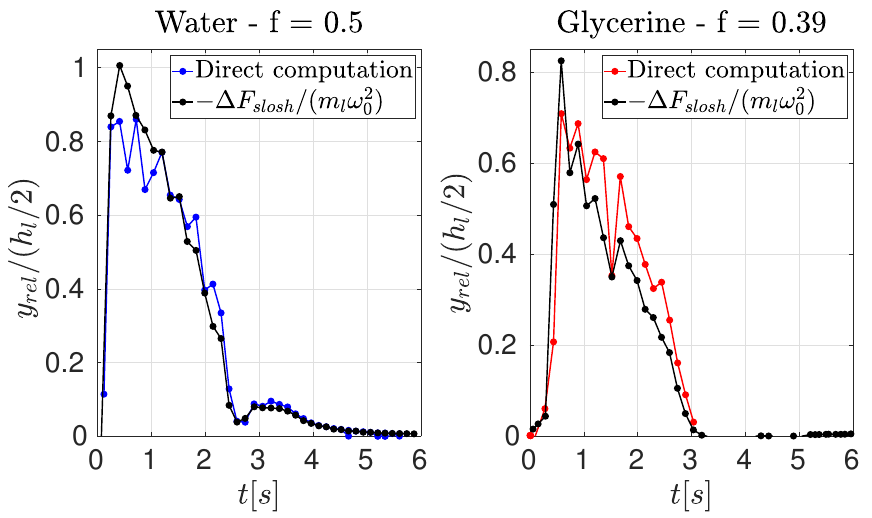
Figure 14. Nondimensional amplitude of the relative motion of the liquid center of gravity with respect to the tank over time for water f = 0.5 ( left ) and glycerine f = 0.39 ( right ). Comparation between SPH calculation and the expression given by Equation (26), − ∆ F slosh / ( m l ω 2